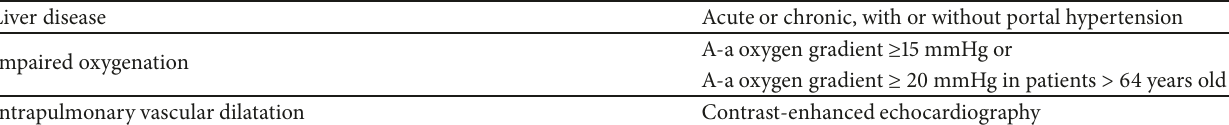
Table 2: Diagnostic criteria for